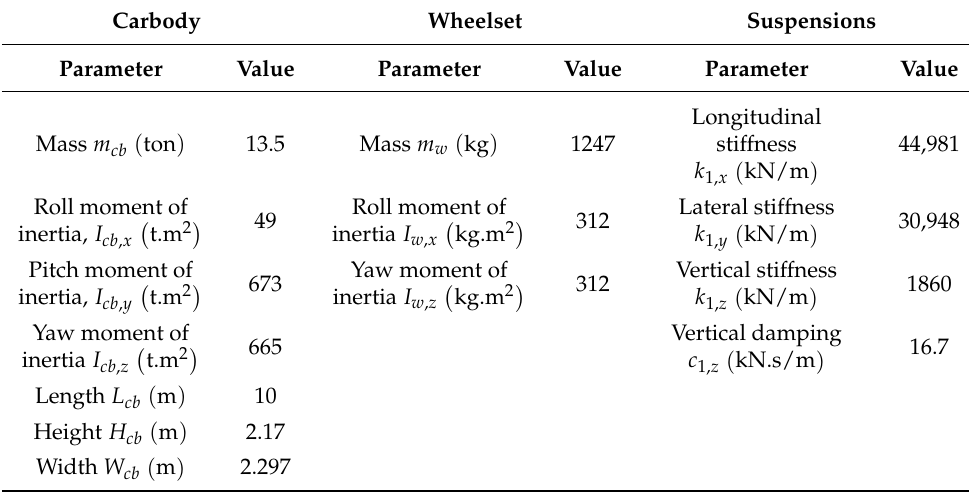
Table 1. Mechanical properties of the freight vehicle model.